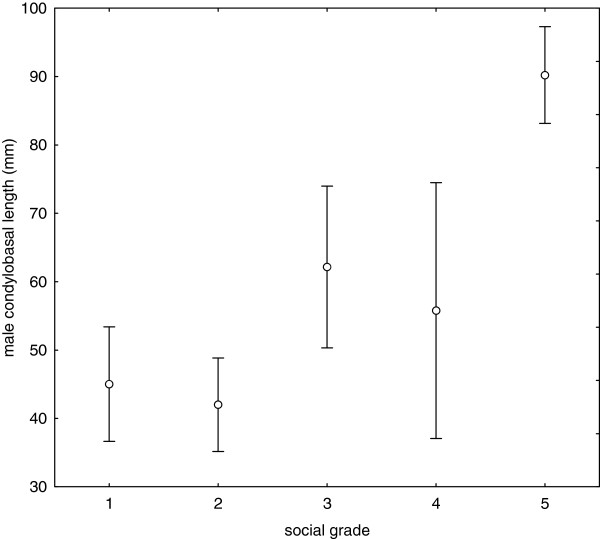
Body size tends to increase with sociality among species of ground squirrels. Results of one-way ANOVA of male condylobasal length results are shown as means and 95-% confidence intervals.